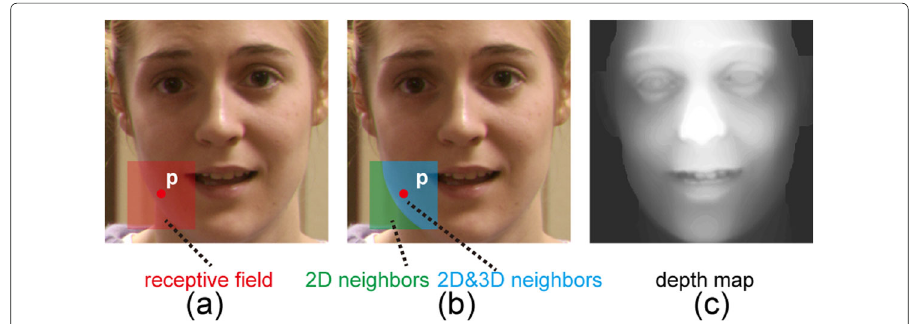
Fig. 1 Receptive field of 2D and 3D cases for input image. Illustrations of a the receptive field and b the difference of 2D and 3D neighbors for a given pixel p , and c the corresponding depth